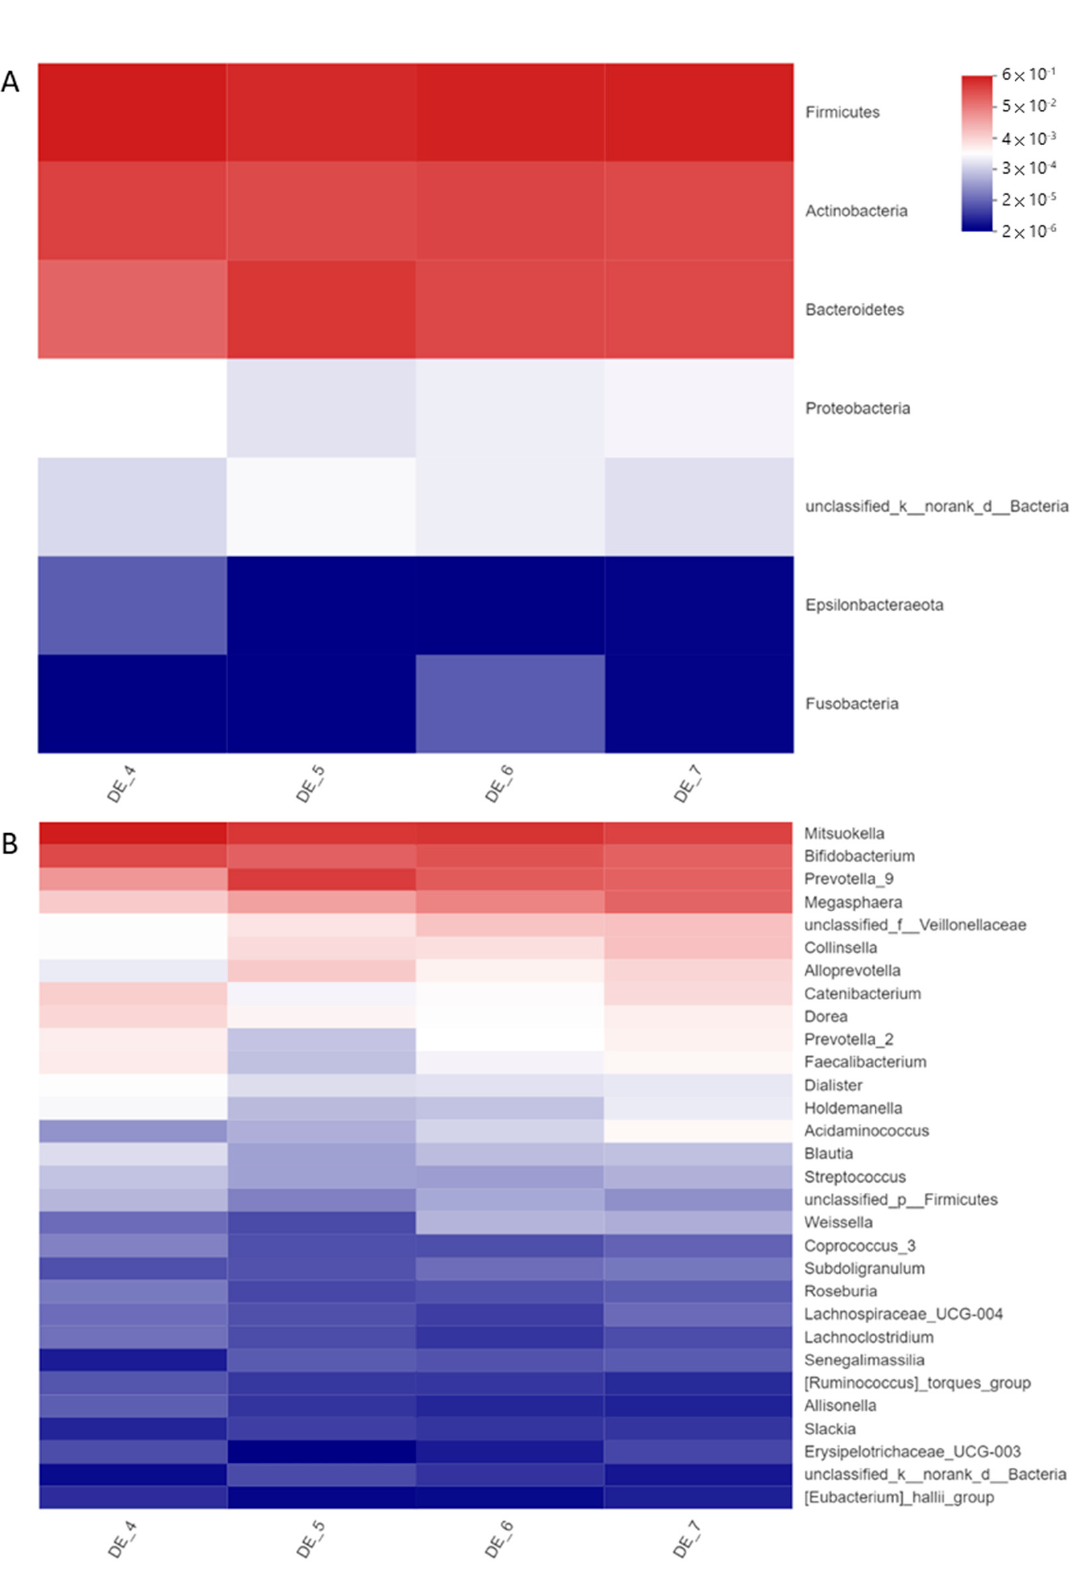
Figure 3. Relative abundance at ( A ) phylum level and ( B ) genus level in resultant microbiota of no DEHP control (DE_4), DEHP-D1 (DE_5), DEHP-D2 (DE_6) and DEHP-D3 (DE_7) Table 2. Alpha diversity indices of resultant fermenter microbiota in DINP experiment.